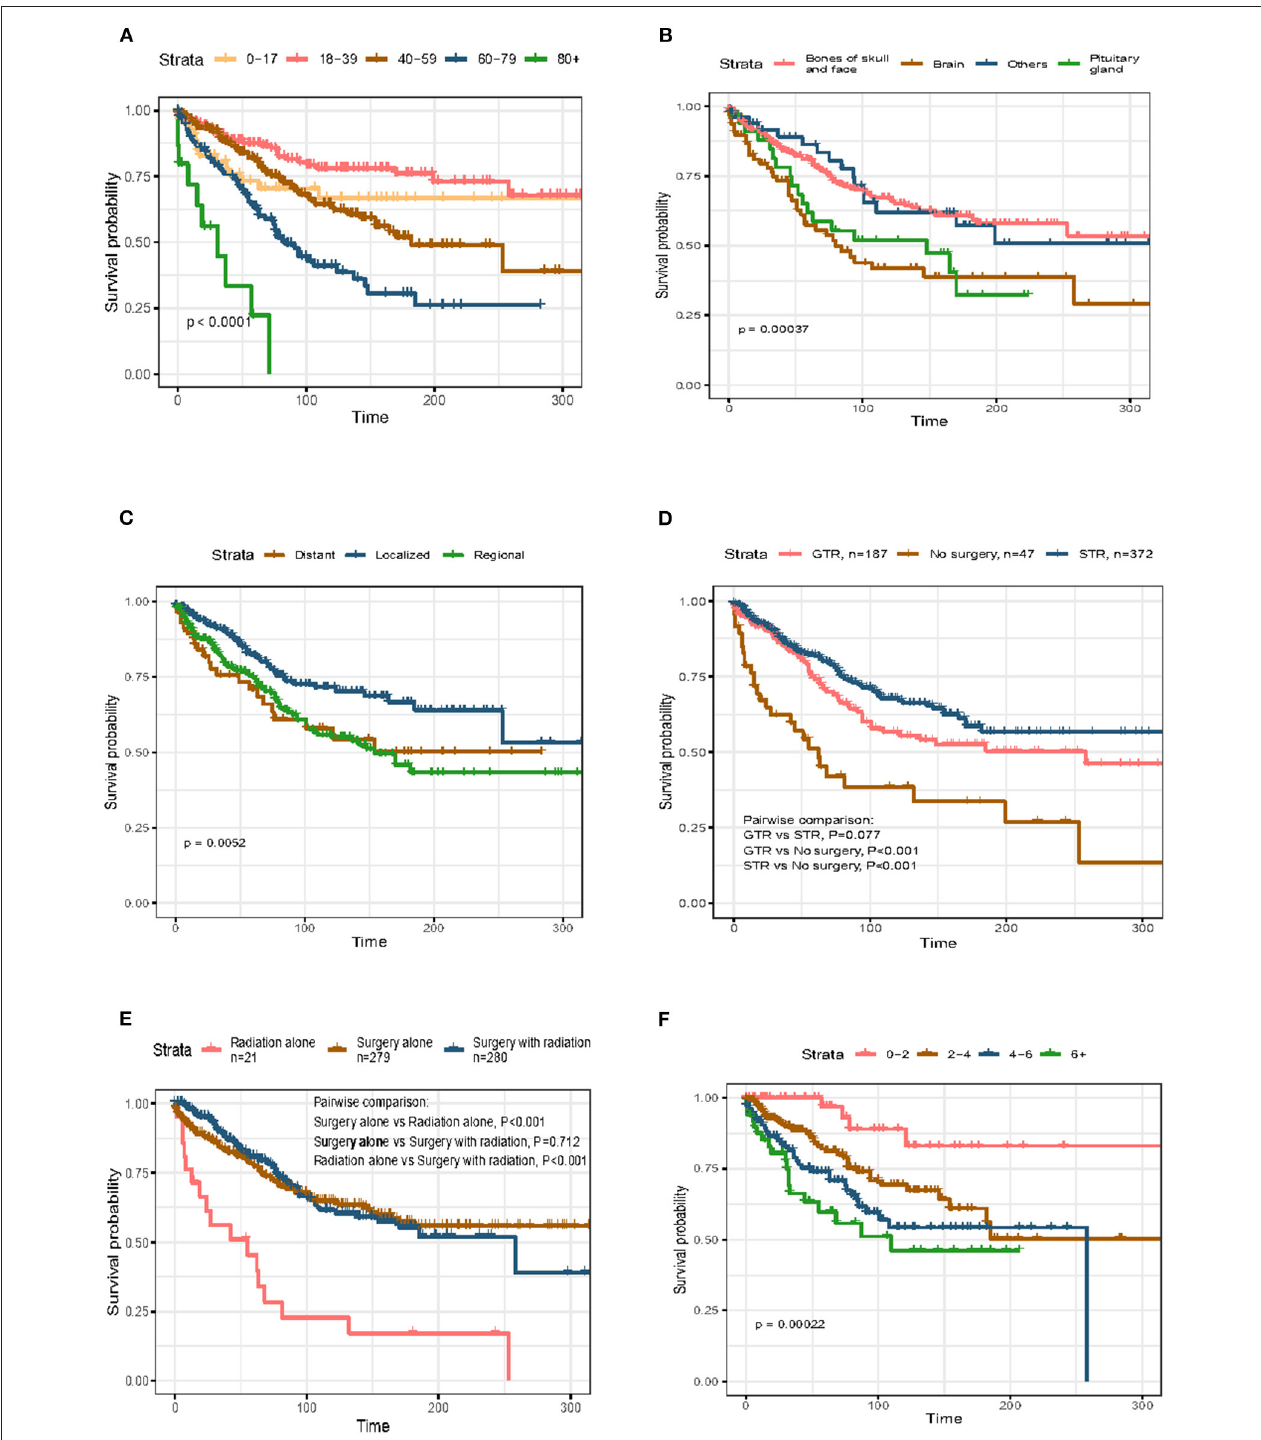
FIGURE 2 | Kaplan–Meier curves (K–M curves) of overall survival (OS) in skull base chordoma patients stratified by (A) age, (B) primary site, (C) disease stage, (D) surgery, (E) therapy, and (F) tumor size.